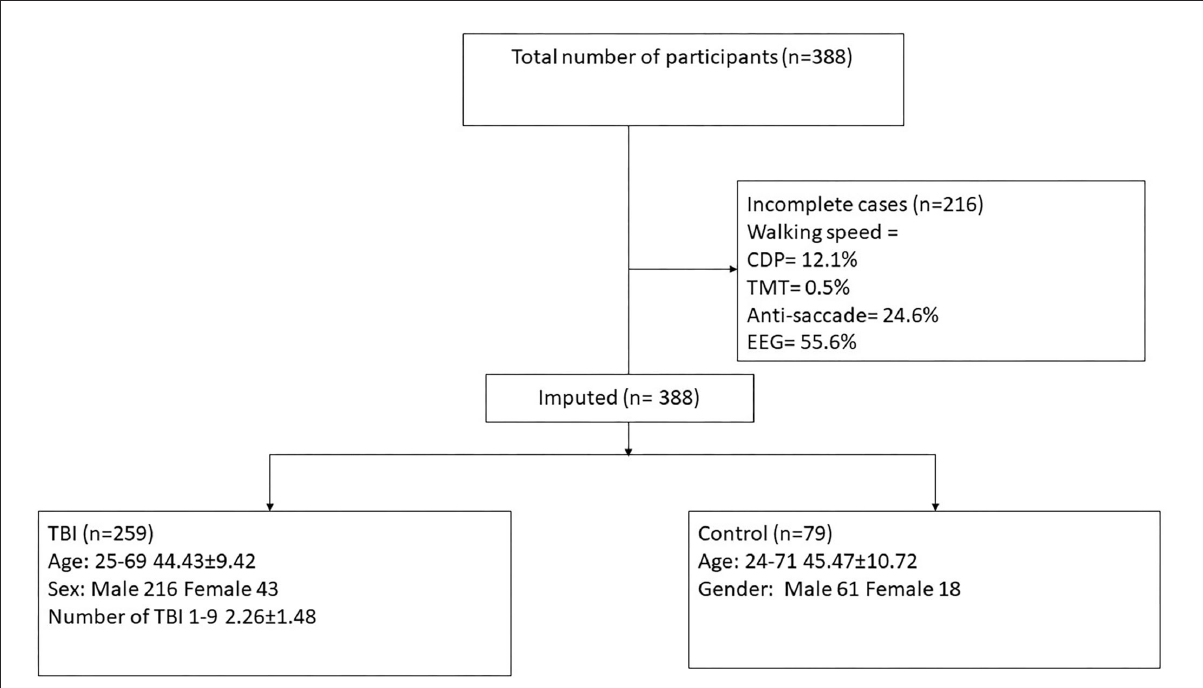
FIGURE1 Consort diagram demonstrating participant selection for the current study. SOT, computerized dynamic posturography; TMT, trail-making test; EEG, auditory oddball task, measuring onset and amplitude of N200 and P300 responses at PZ and FZ; TBI, traumatic brain